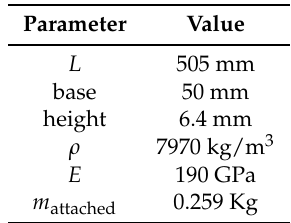
Figure 11. Illustration of the experimental setup. Table 4. Specifications of the experimental